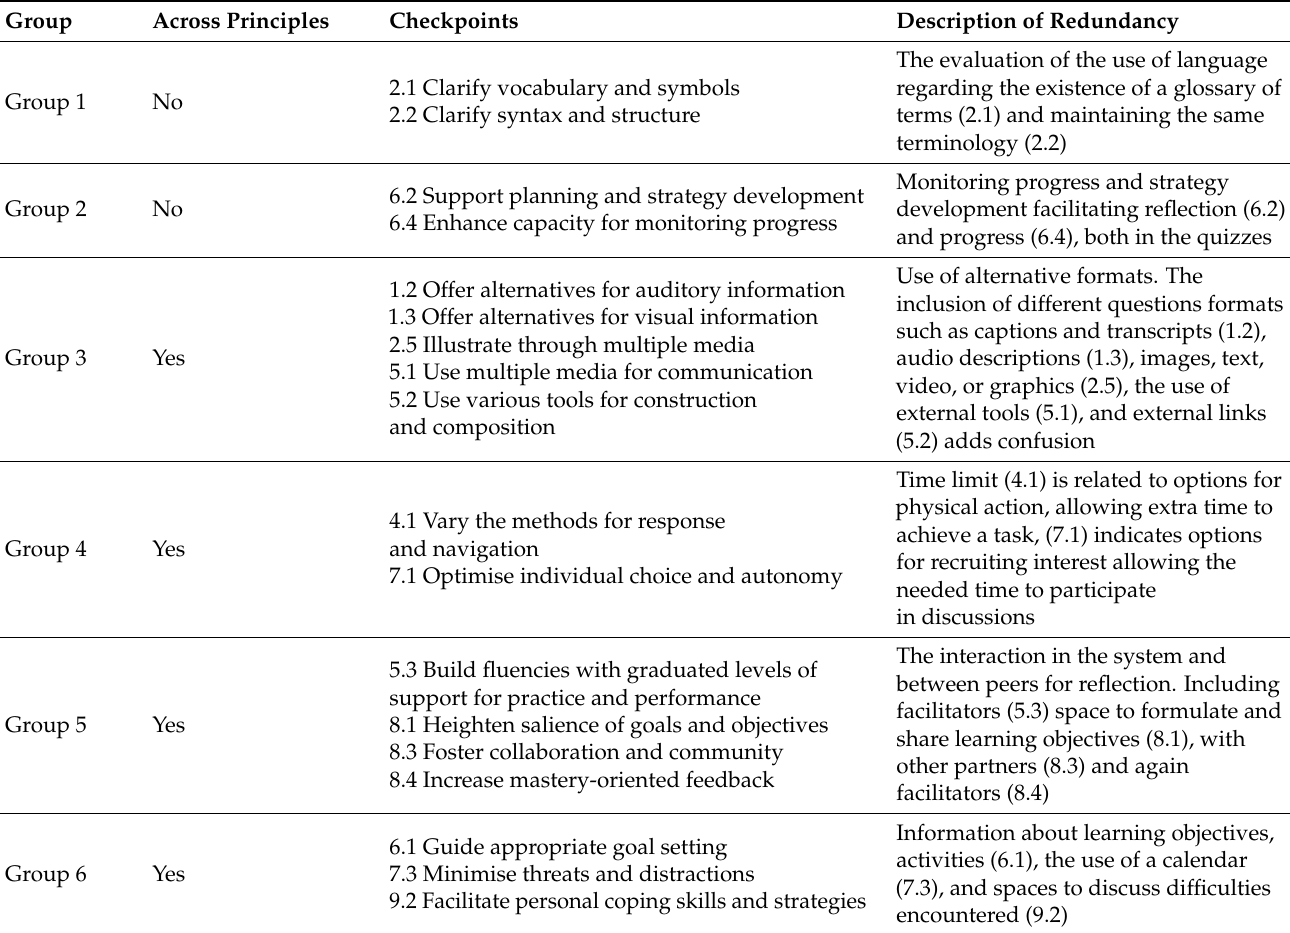
Table 5. Checkpoints identified as redundant by